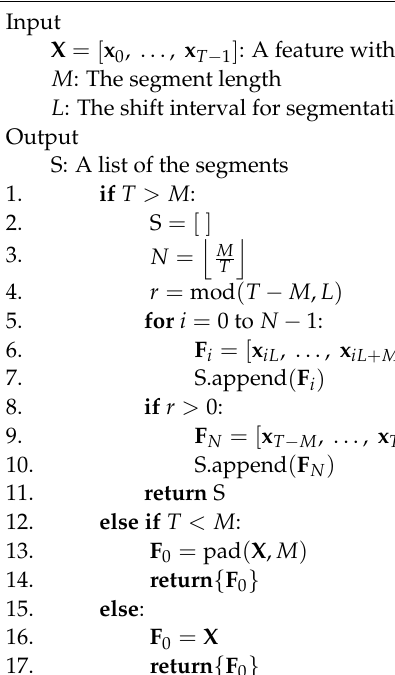
Figure 1. The overview of the conventional feature segmentation when ( left ) M < T and ( right ) M > T , where X = [ x 0 , . . . , x T − 1 ] is a feature with the length of T , M is the segment length, L is the shift interval for segmentation, and F i is the i -th segment. Algorithm 1 Pseudocode of Conventional Feature Segmentation